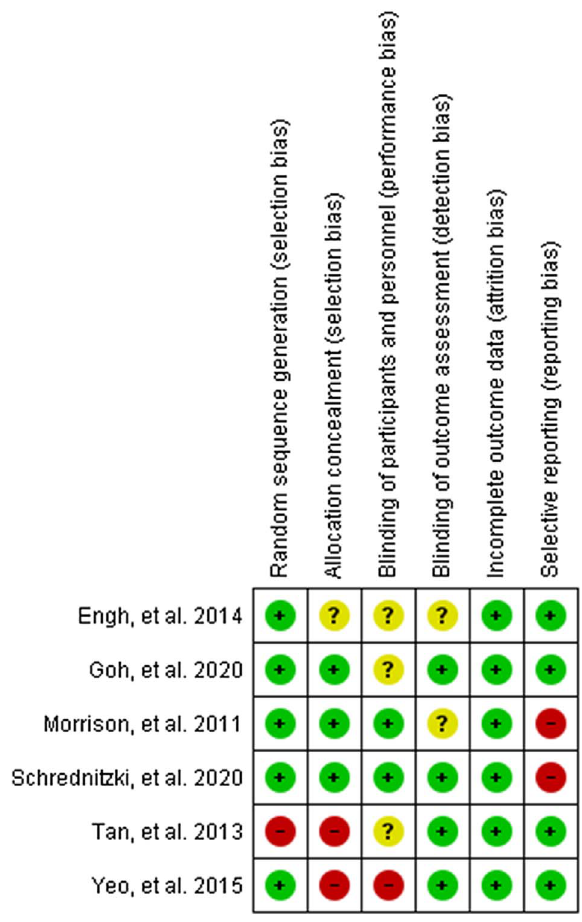
Figure 3. Risk of bias summary: review authors ’ judgments about each risk of bias item for each included